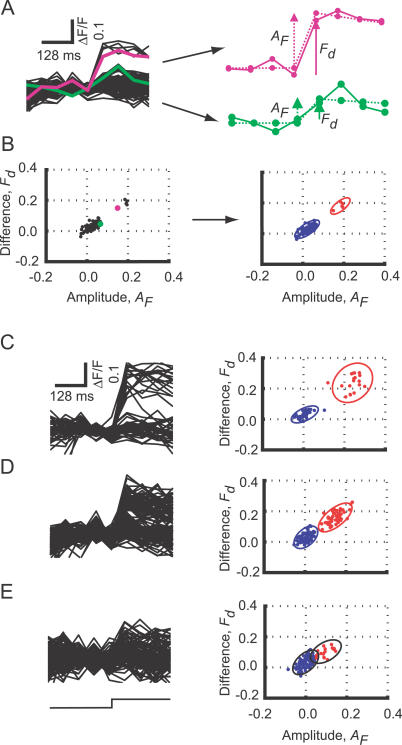
Distinguishing Successes and Failures in Response to Whisker Deflection(A) Left: multiple fluorescence transients from a single cell aligned on the whisker stimulus. Right: analysis of two representative trials (green and pink traces on the left). For each trace, two values, the difference F
d (solid arrows) and the amplitude A
F (dashed arrows) were computed. The dotted lines are the results of template matching.(B) Left: the F
d and A
F were plotted for each trial. Right: these points were clustered into two groups (red, successes; blue, failures). The 95% confidence ellipses are overlaid on the graph. The green and pink dots are from the two representative trials shown as the green and pink traces in (A), respectively.(C–E) Analysis for three different cells. (C) Well-separated cell. (D) Marginally separated cell. (E) Example of a cell in which successes and failures overlapped.